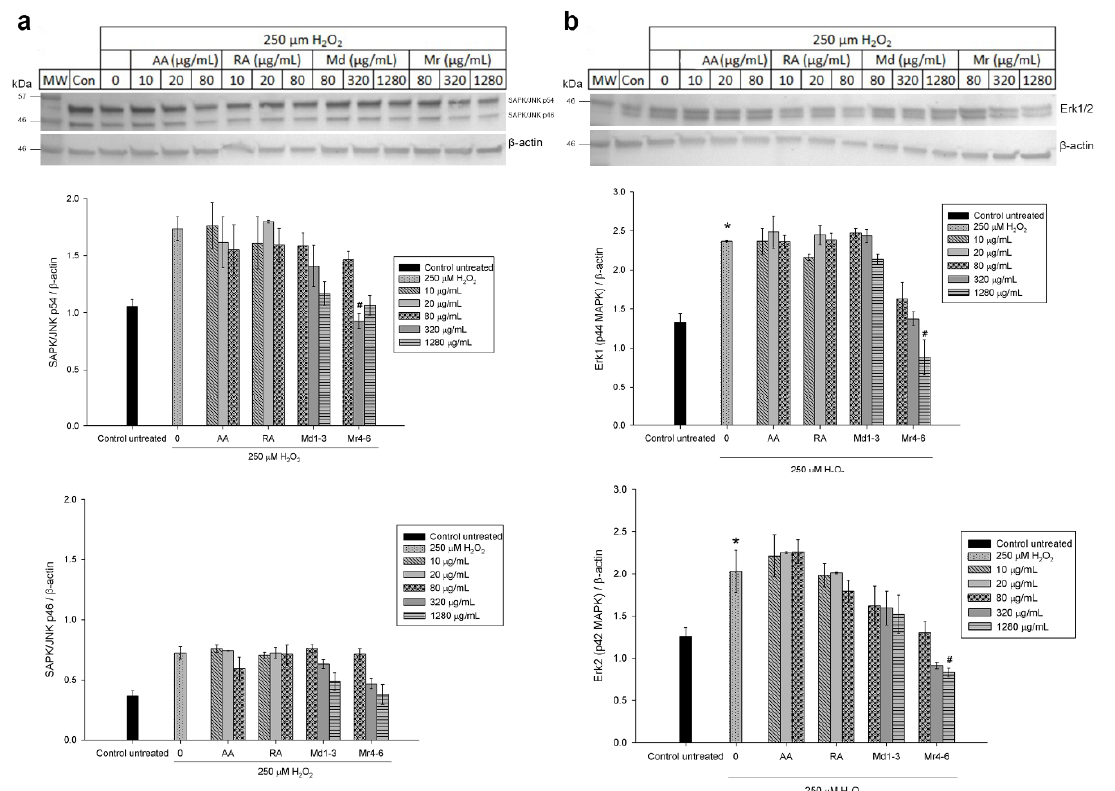
Figure 6. Western blot analysis of di ff erent concentrations of ascorbic acid, rosmarinic acid and mint extracts on the expression of ( a ) SAPK / JNK and ( b ) Erk1 / 2 (p44 / 42 MAPK) in H 2 O 2 -induced damage in SH-SY5Y cells. Results are presented as mean ± standard error (SE) ( n = 3). * indicates that treatment with H 2 O 2 is significantly di ff erent ( p < 0.05) from control untreated cells # indicates that pretreatment with mint extracts, AA or RA is significantly di ff erent ( p < 0.05) from H 2 O 2 -treated cells. AA: ascorbic acid, RA: rosmarinic acid, Md1-3: Mentha diemenica and Mr4-6: M. requienii .